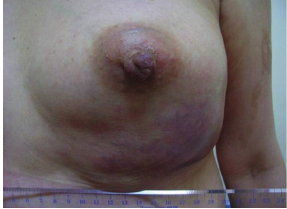
Figure 1: The patient presents with left breast swelling.